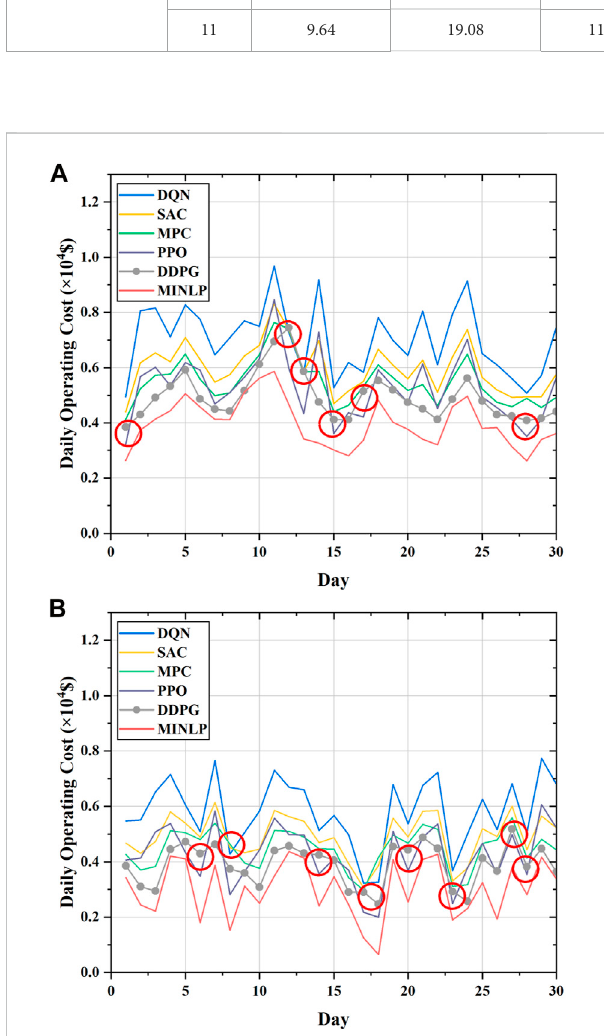
FIGURE 13 Daily operating cost over 30 consecutive days obtained by the proposed approach and the comparison methods: (A) Daily operating cost in the test set for June; (B) daily operating cost in the test set for November.